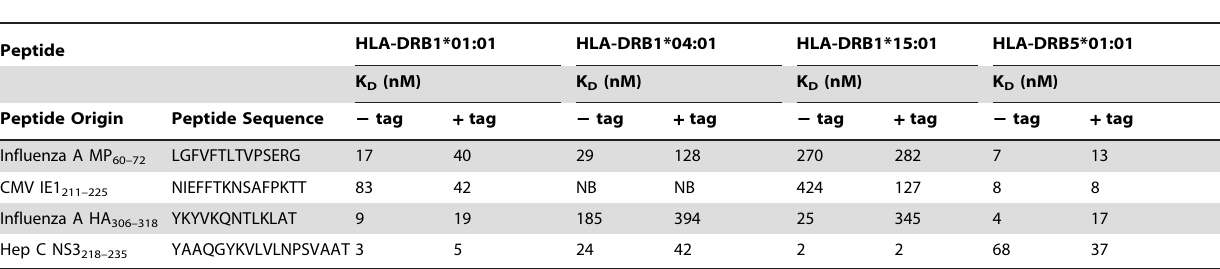
Table 1. Peptide-HLA class II affinity measurements (in nM) of H 6 - vs. non-H 6 -tagged peptides with four different HLA class II